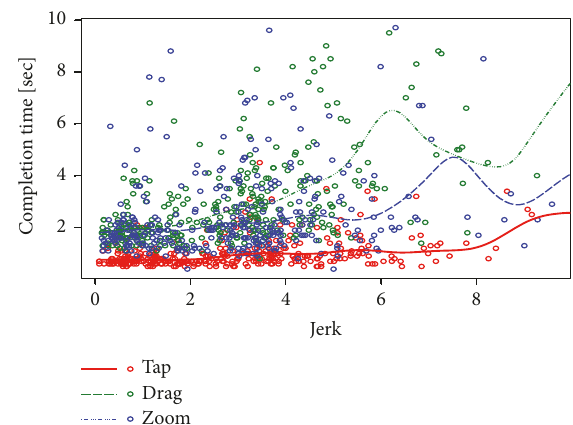
Figure 15: Completion time for the three task types depending on RMS of jerk intensity, with standard Gauss kernel and a smoothing window of size